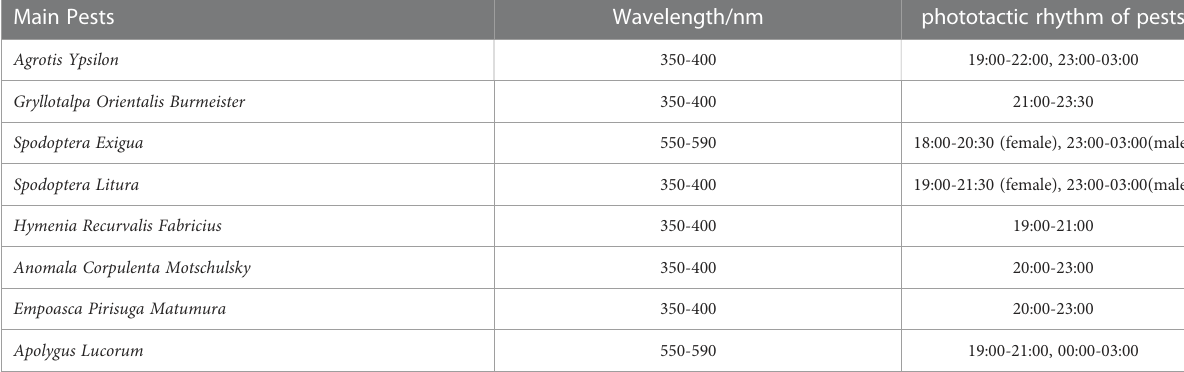
TABLE 6 Effect of wavelength on the phototactic rhythm of main pests in vineyard. Main